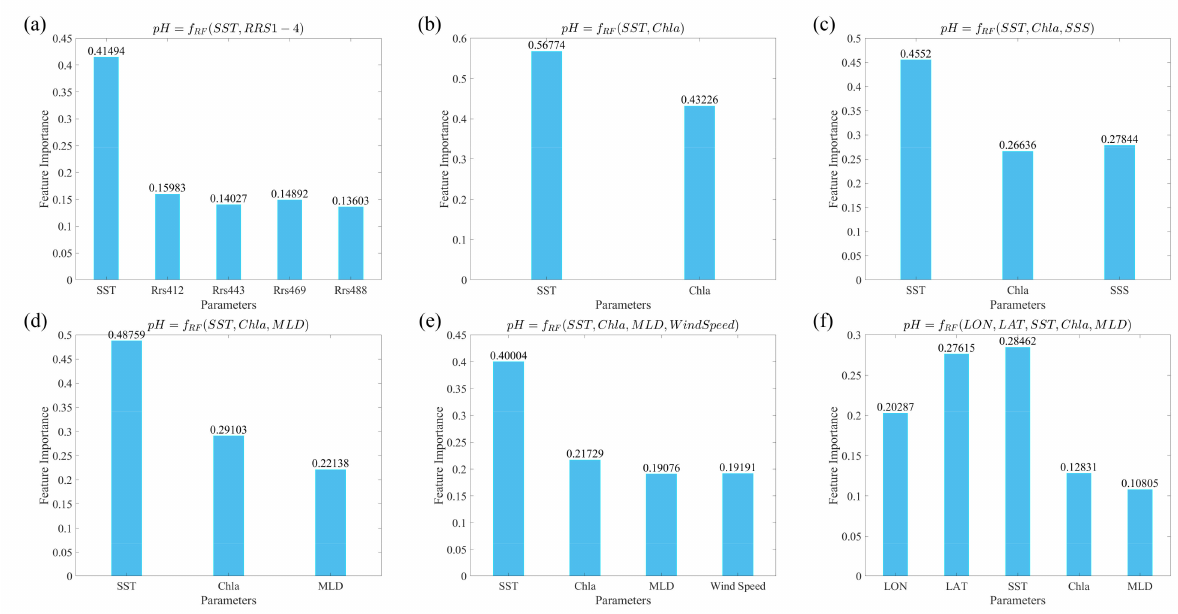
Figure 10. Feature Importance of sea surface pH remote sensing inversion model. ( a – f ) are for experiments of